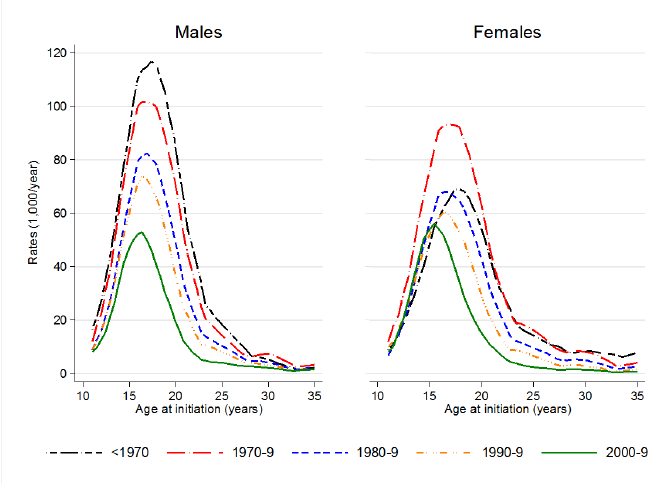
Fig 1. Crude rates of smoking initiation according to age, by sex and period. All European regions